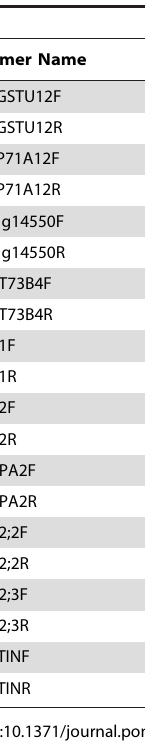
Table 2. Primers used for microarray verification qPCR reactions.